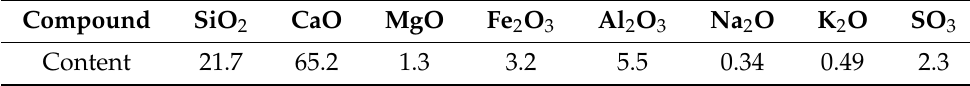
Table 1. Chemical specimen composition of the cement